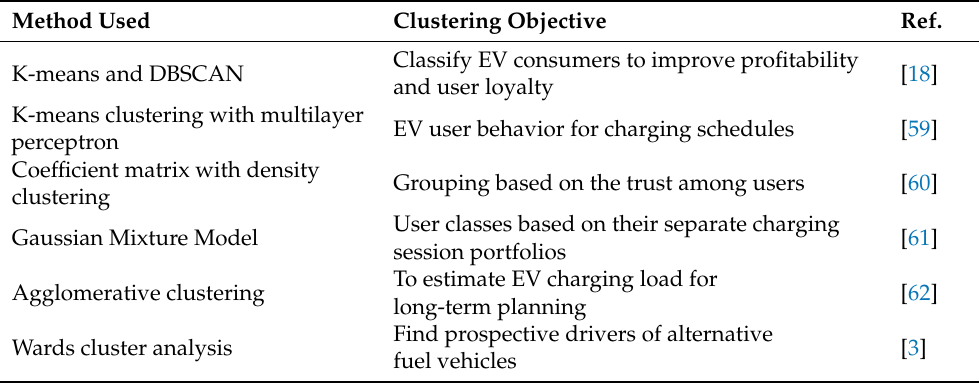
Table 3. Summary of clustering methods along with their objectives for user behavior-based clustering of EVs.